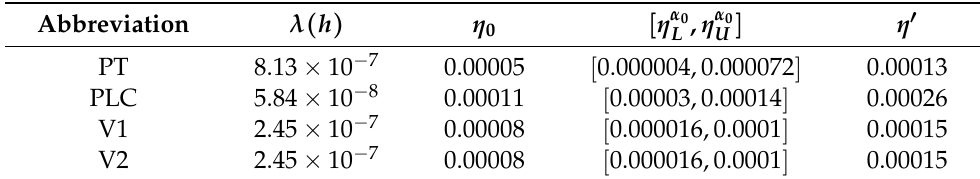
Table 1. Failure rates and failure rate cumulated parameter of equipment in pressure vessel safety instrument